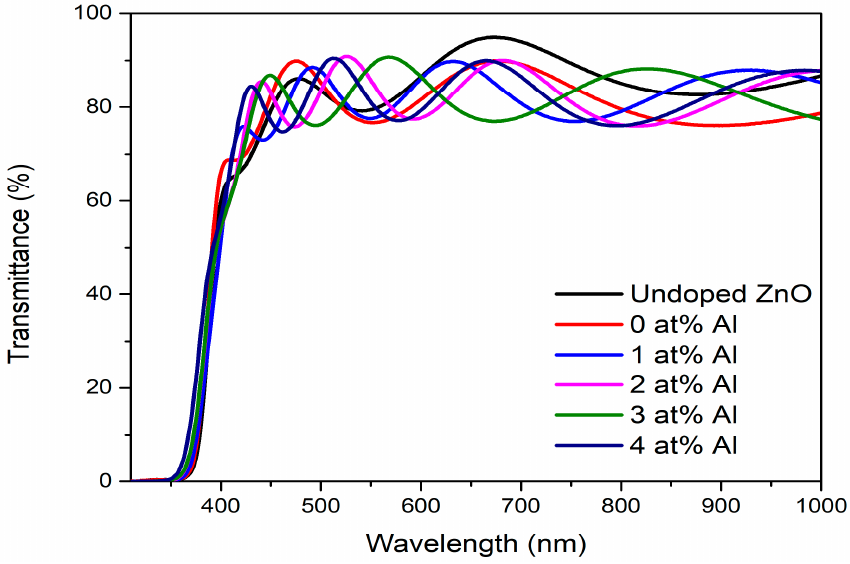
Figure 4. Transmittance spectrum of (Gd, Al) co-doped ZnO films with the variation of the Al concentration.